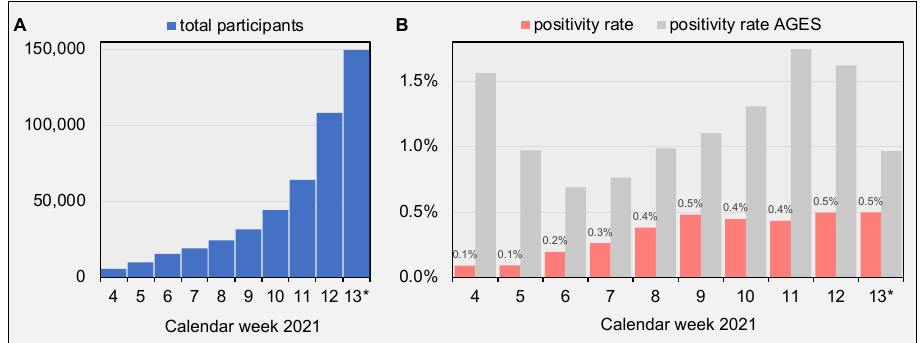
Figure 1. ( A ) Total number of weekly participants. During a study period of 66 days (25 January–31 March), a total number of 400,730 samples were collected. ( B ) Fraction of positive test results of total weekly tests (red bars). Grey bars represent total positivity rate of all tests conducted in Vienna as reported by the Austrian Agency for Health and Food Safety (AGES; https://covid19-dashboard.ages.at; accessed on 8 June 2021). * study period ended at day 3 of calendar week 13 (31 March).